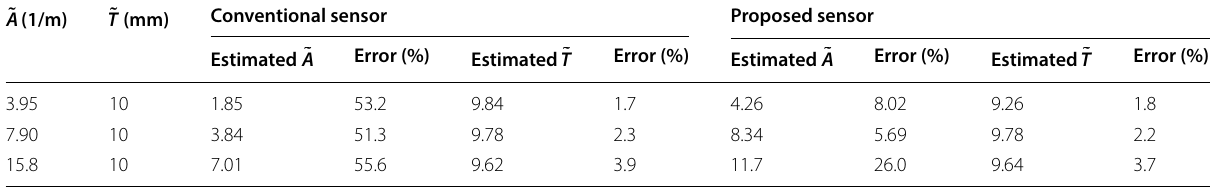
Table 1 Results of curvature amplitude amplitude is changed, and the respective error rates ˜ A (1/m) ˜ T